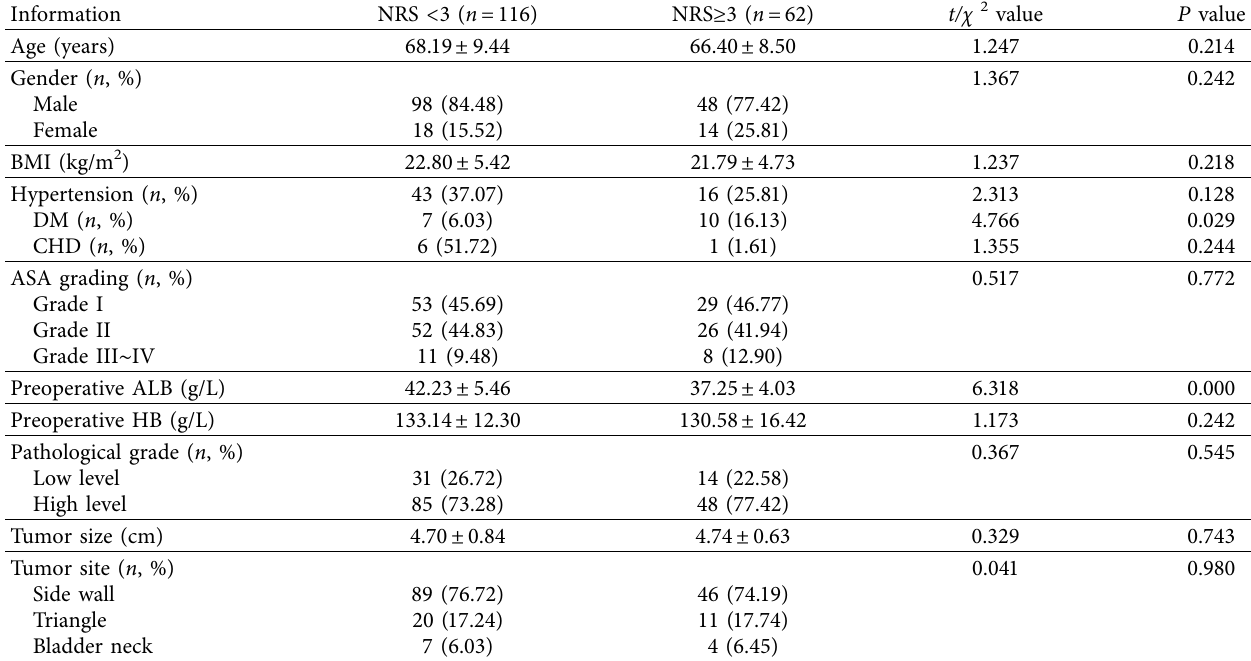
Table 2: Comparison of clinicopathological characteristics.